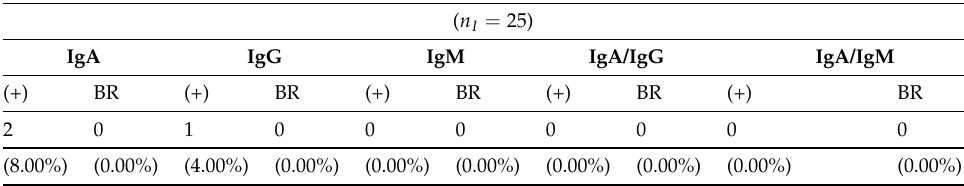
Table 4. Positive rates of the serological assay in HCWs* included in the study from Eko-Prof-Med HCU in Miasteczko ´Sl